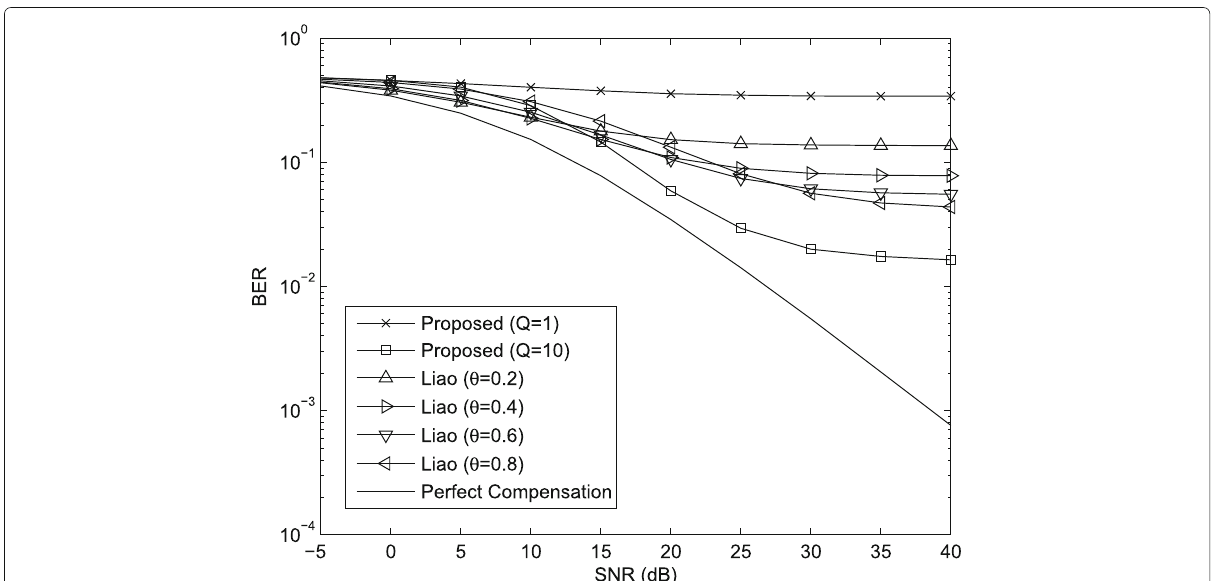
Fig. 7 Comparison of the BER for K = 50. We compare the BER performances of our method with the method proposed by Liao et al. in [34]. The parameter θ in Liao’s algorithm is set to 0.2, 0.4, 0.6, and 0.8. The number of received blocks is K = 50